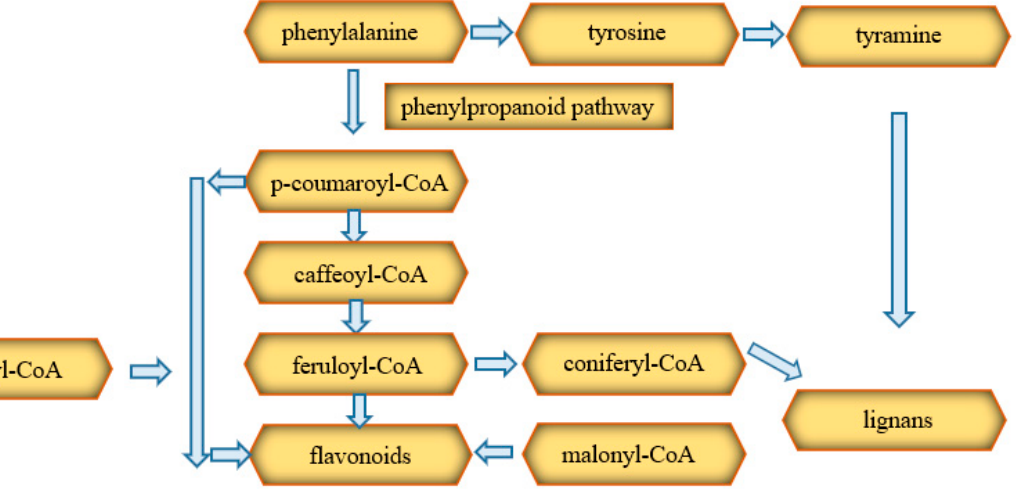
Figure 7. Diagram of the biosynthesis of phenolic compounds [42].